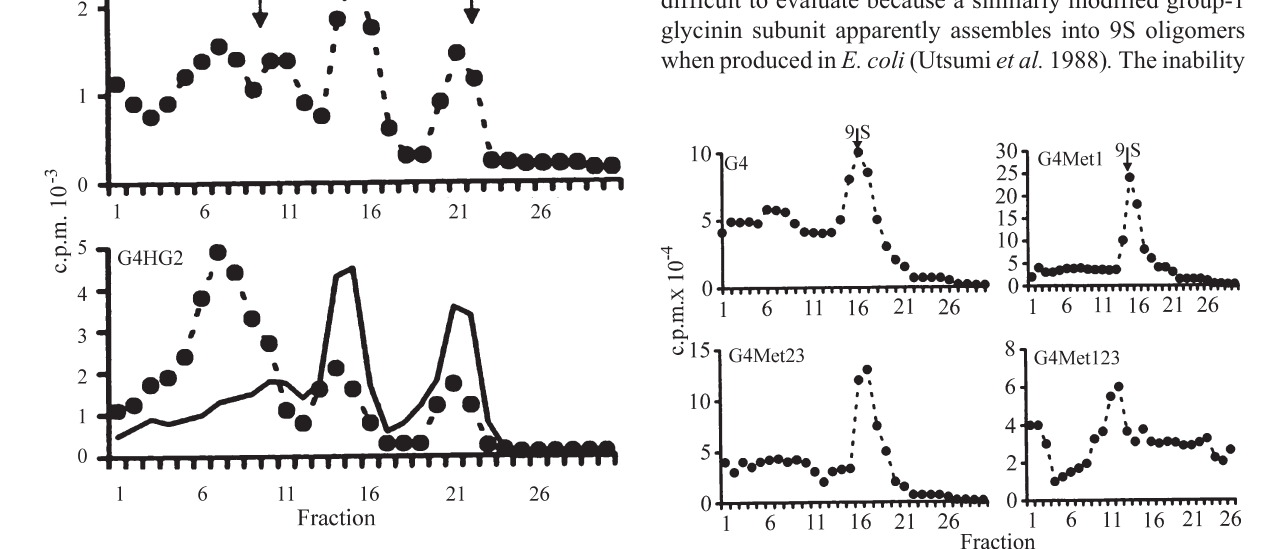
Figure 5 - Radioactively labeled G4, G2HG4 or G4HG2 proglycinins in 0.4 M NaCl were incubated with dissociated glycinin subunits for 24 h at 25 °C. The distribution of radioactively labeled protein was determined following sucrose density gradient centrifugation. The distribution ob- tained with G4 is shown as a control and is indicated by a solid line. The position of sedimentation standards in the sucrose gradients is shown at the top of the figure.